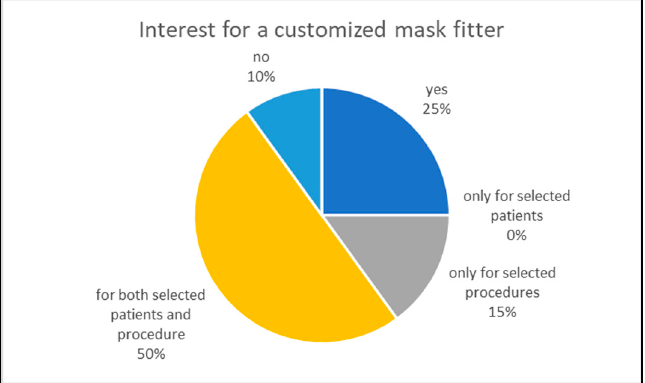
Figure 10. Interest in wearing the Mask Fitter routinely.